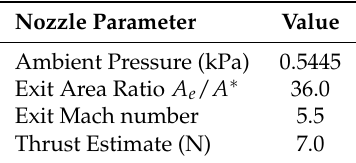
Table 2. Nozzle operating parameters and thrust prediction for the prototype under assumed steady-state conditions.